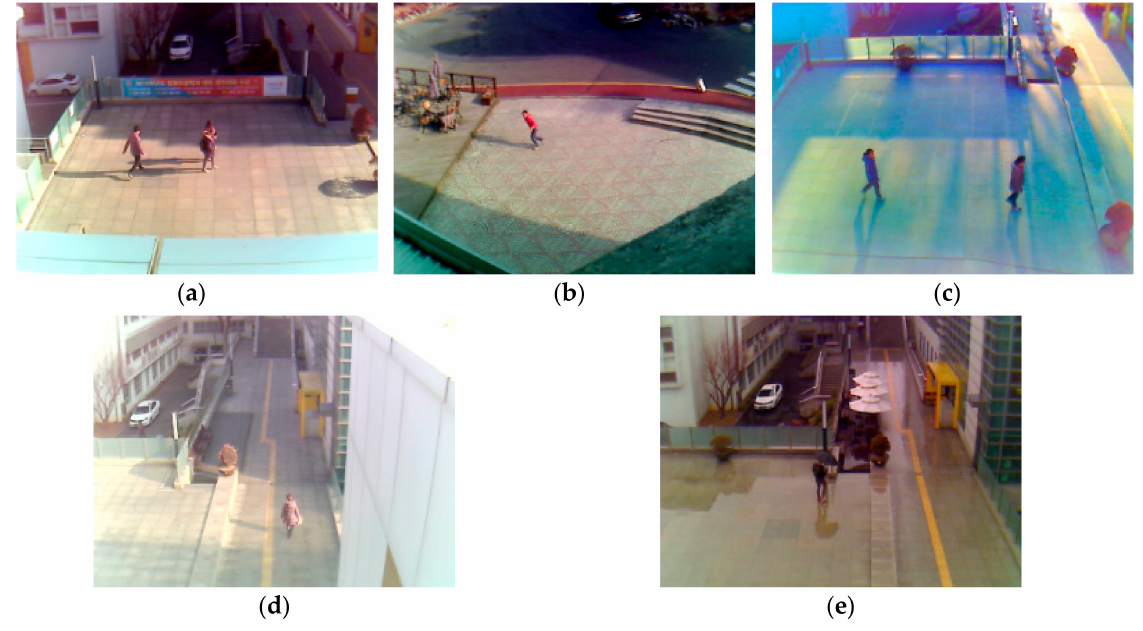
Figure 4. Various images of the experimental database for this research: ( a ) Sub-database 1; ( b ) Sub-database 2; ( c ) Sub-database 3; ( d ) Sub-database 4; and ( e ) Sub-database